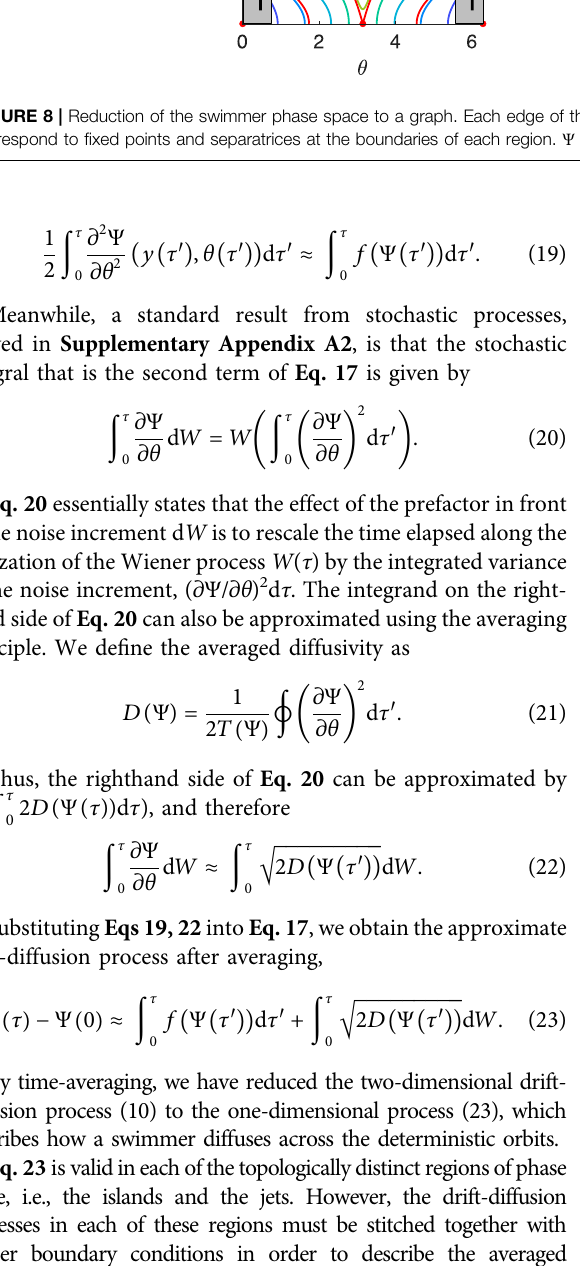
Frontiers in Physics |